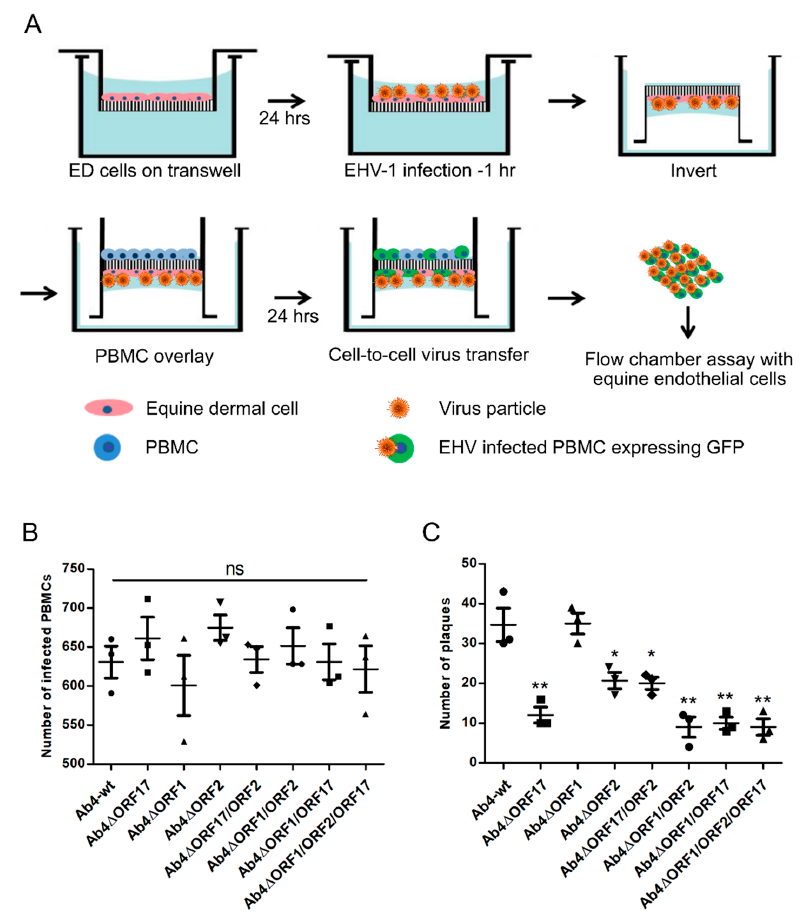
Figure 5. EHV-1 spread between epithelium, PBMC, and EC. ( A ) ED cells were seeded into 3-µm pore size 24-well transwell inserts and incubated at 37 °C for 24 h. Subsequently, ED cells were infected with Ab4-wt or mutant viruses at an MOI of 0.1 for 1 h and treated with citrate buffer. Upon infection, transwell insert was inverted, and 1 × 10 5 PBMC resuspended in medium containing virus-neutralizing antibodies were added. ( B ) Epithelium-to-PBMC virus transfer was assessed by counting the number of EGFP-positive cells after 24 h. ( C ) Subsequently, infected PBMC were used for flow chamber assay. The data represent means ± SD of three independent experiments. One-way ANOVA was done followed by correction for multiple comparisons; *— p < 0.05, **— p < 0.01. ns—not